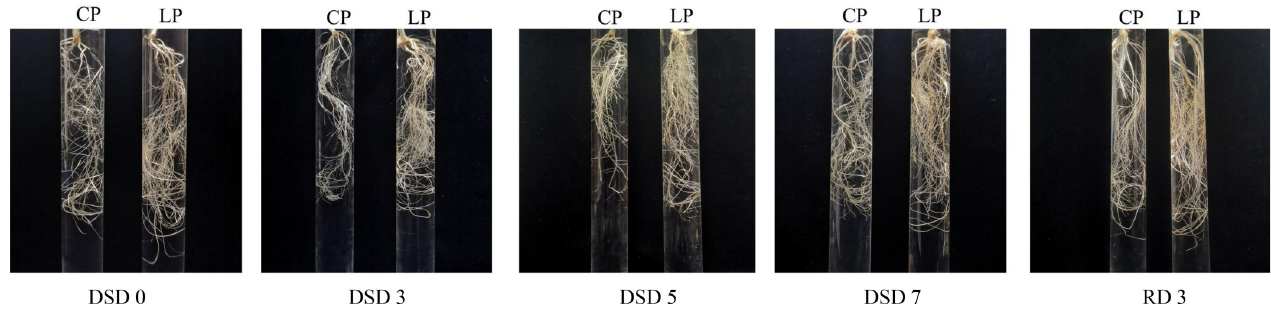
Fig 1. Morphology of wheat roots in CP and LP treatments under drought stress. Note: CP: conventional phosphorus; LP: low phosphorus.